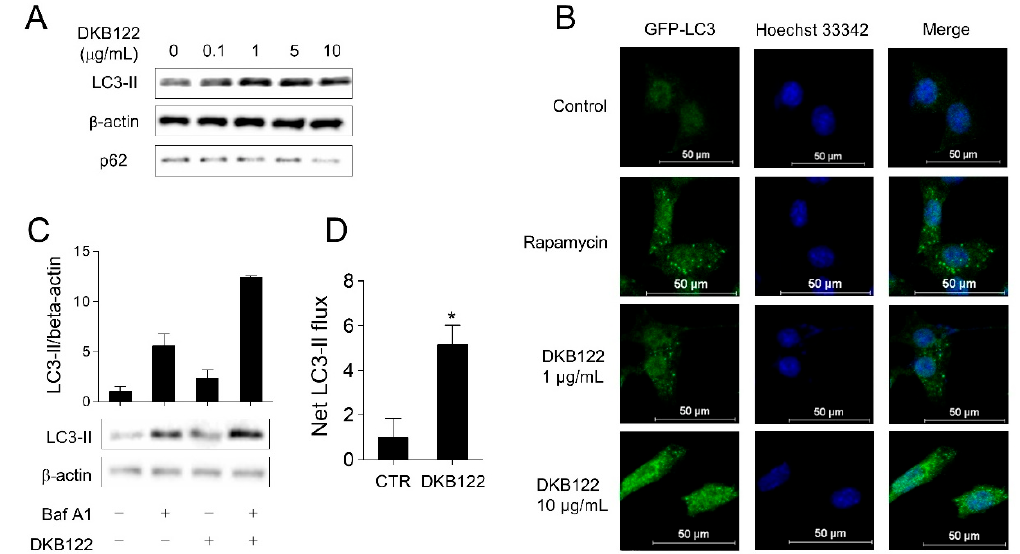
Figure 6. Activation of autophagic flux by DKB122. (A) HEI-OC1 cells were incubated with DKB122 (0.1–10 µ g / mL) for 24 h, then harvested. LC3-II and p62 protein levels were detected using western immunoblotting. β -Actin was used as a loading control. ( B ) After transfection with a plasmid expressing GFP-LC3, HEI-OC1 cells were treated with DKB122 (1–10 µ g / mL) for 8 h. Rapamycin (1 µ M, 6 h) was used as a positive control. Intracellular GFP-LC3 puncta (green) were tracked using confocal microscopy. Nuclei were stained with Hoechst 33342 (blue). ( C ) HEI-OC1 cells were exposed to DKB122 (5 µ g / mL, 8 h) and / or Bafilomycin A1 (1.5 nM, 4 h). Then, the LC3-II level was examined using western immunoblotting. ( D ) The increase in autophagic flux by DKB122 was calculated in comparison to that of the untreated group. The results are presented as mean ± SD ( n = 3, * p < 0.05).